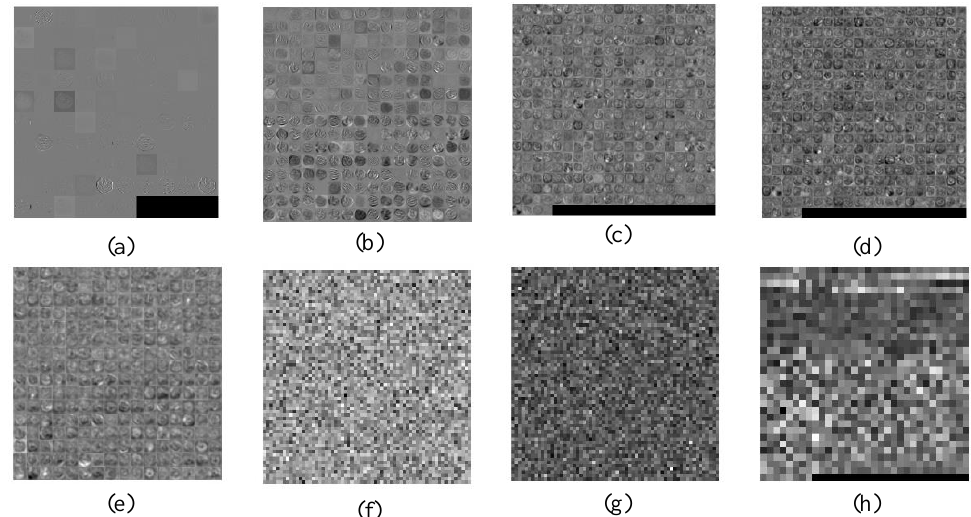
Figure 6. ( a – e ) Feature extraction results of convolutional layers C1, C2, C3, C4, and C5. ( f – h ) Feature extraction results of fully connected layers FC6, FC7, and FC8.